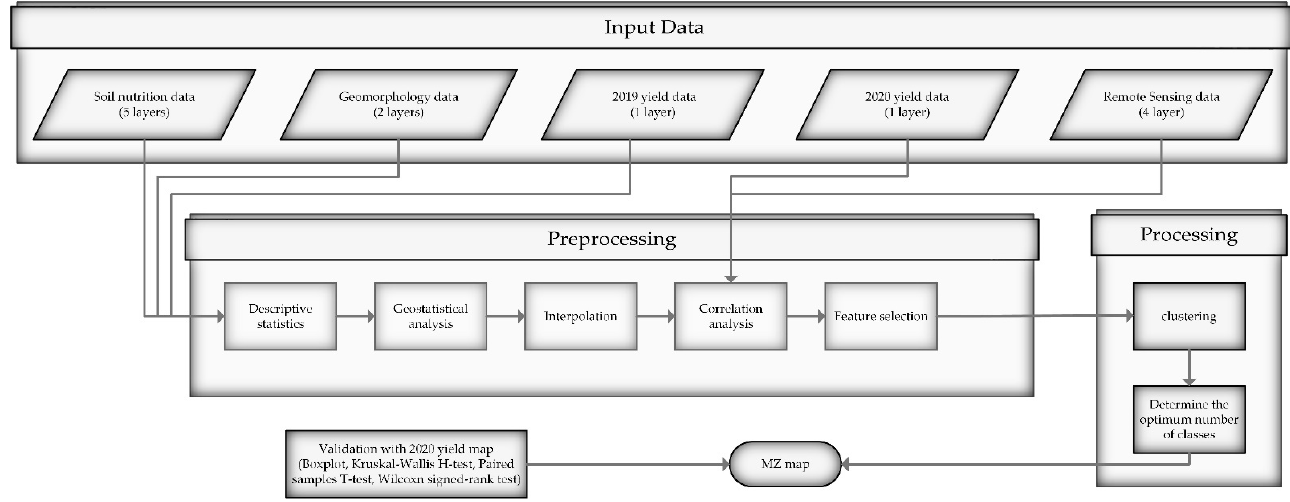
Figure 3. The workflow of model-2 (hybrid-based, unsupervised clustering). Input Data